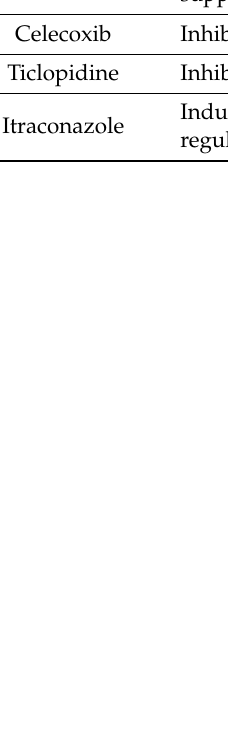
Table 2. Mechanisms of action and growth-promoting pathway targeted by each drug in the